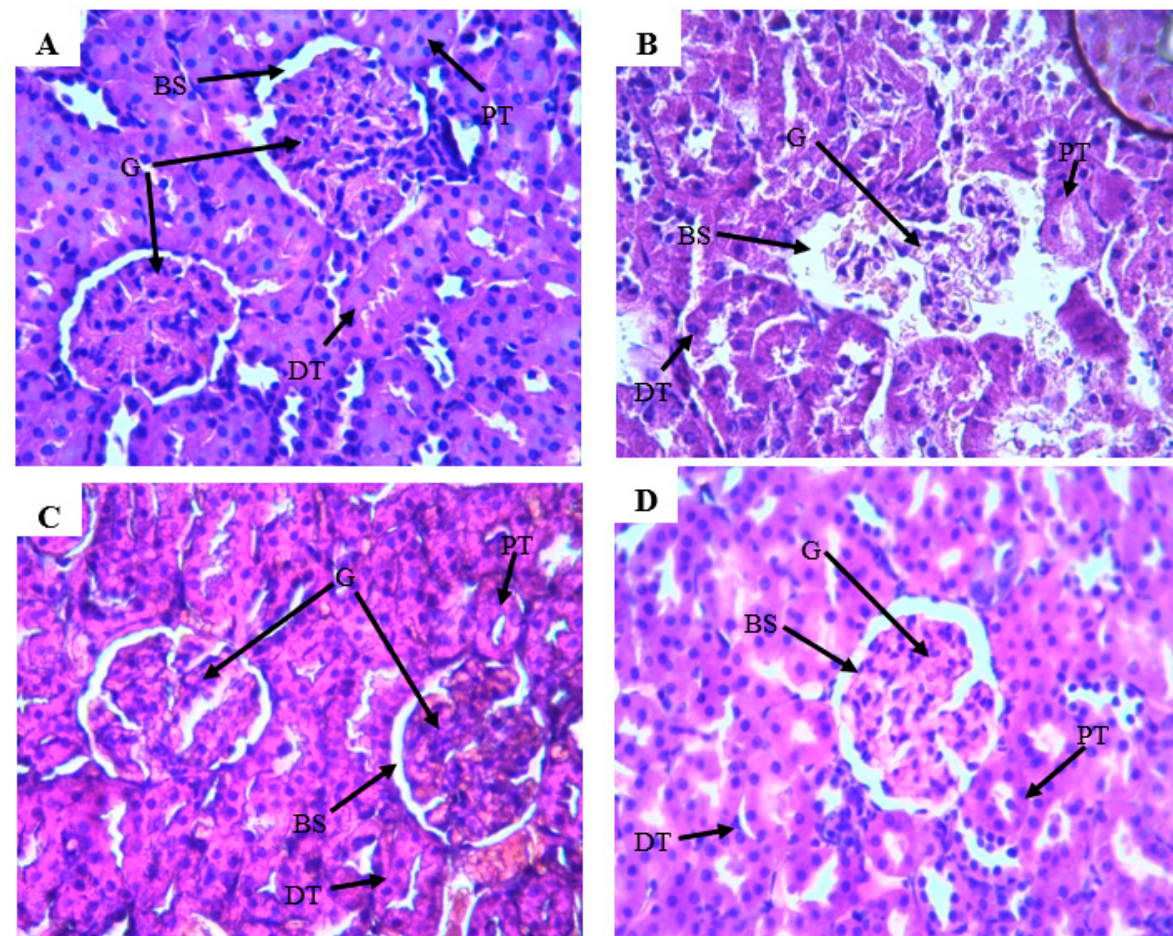
Figure 9. The effect of ZLF extracts on kidney histology in GM-exposed rats. Hematoxylin and eosin staining is used to visualize histological parts, which were then examined under an optical microscope at a magnification of ×40. ( A ) Control group, ( B ) GM treated Group, ( C , D ) groups intoxicated with GM and treated with ZLF’s extract at doses 200 and 400 mg/kg. Glomerulus (G), Distal convoluted tubule (DT), Bowman space (BS), Proximal convoluted tubule (PCT).